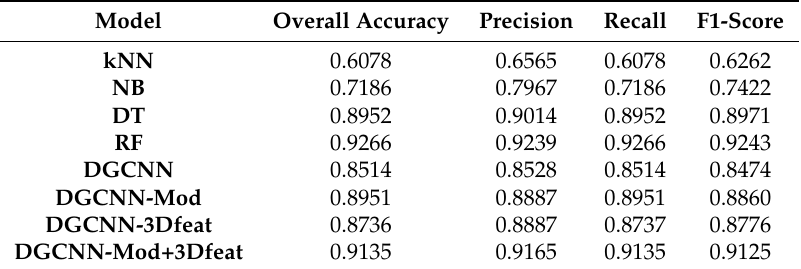
Table 4. Weighted metrics computed for the Test set of the SMG